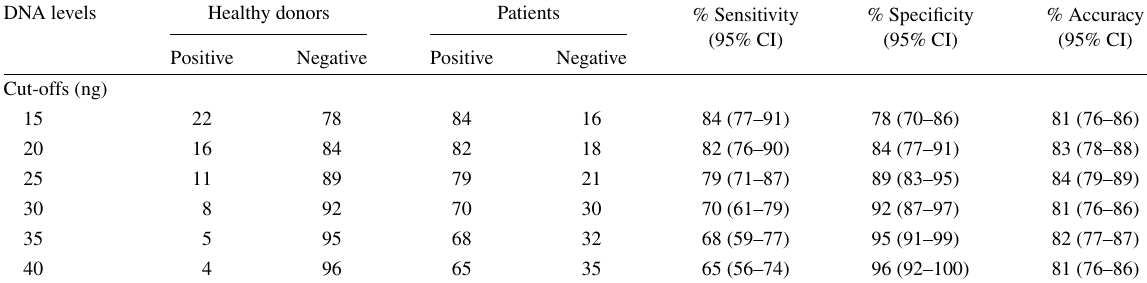
Sensitivity and specificity of FL-DNA analysis